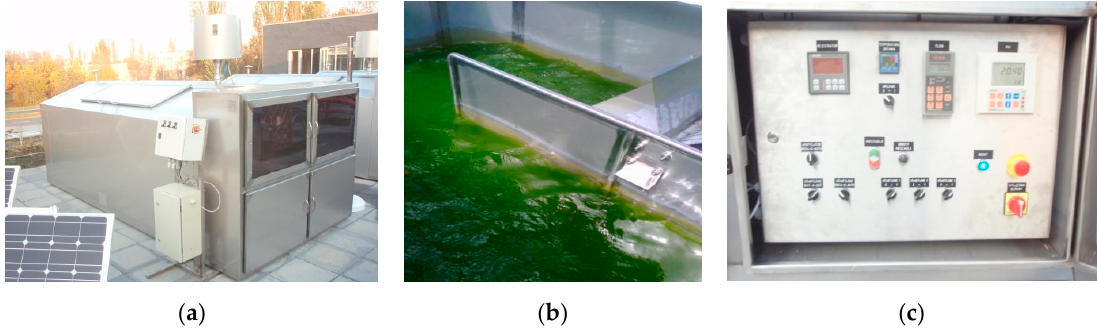
Figure 1. The photobioreactor: ( a ) a general view, ( b ) a chamber for microalgae cultivation and ( c ) a control system.